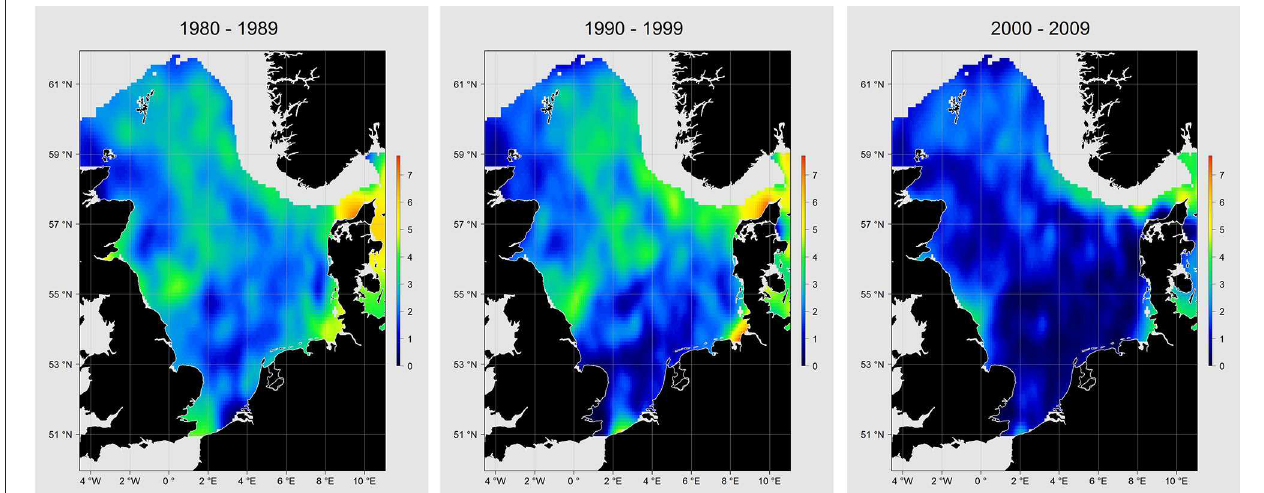
FIGURE 6 | Production of gridded map layers using geospatial modeling, showing the average abundance of Cod (Gadus morhua) in the North Sea showing stock depletion. Scale: log-transformed CPUE.